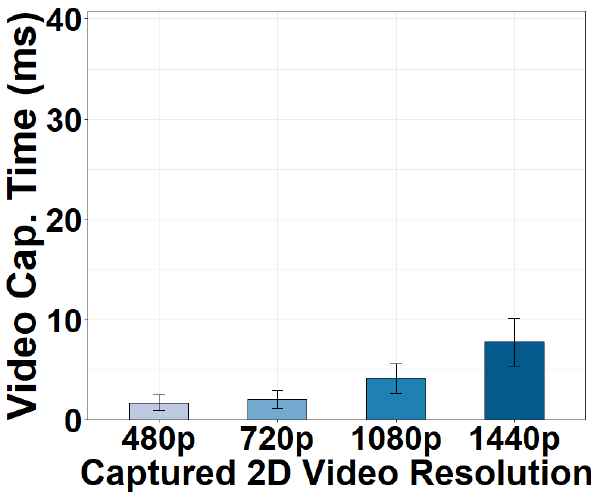
Figure 3. Video capture time versus capture